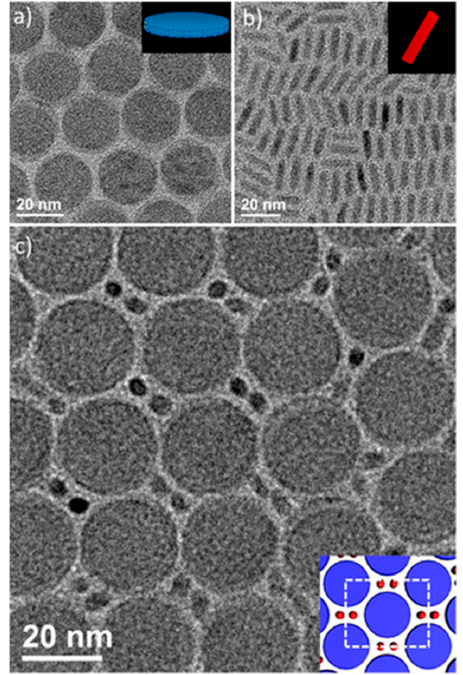
Figure 9. TEM images of binary superlattices of two anisotropic NC building blocks. ( a ) LaF 3 nanodisks, ( b ) CdSe/CdS nanorods, and ( c ) AB 2 BNSLs of LaF 3 nanodisks and CdSe/CdS nanorods. Inset is the illustration of the BNSL structure. Reproduced with permission from [54]. Copyright American Chemical Society, 2015.